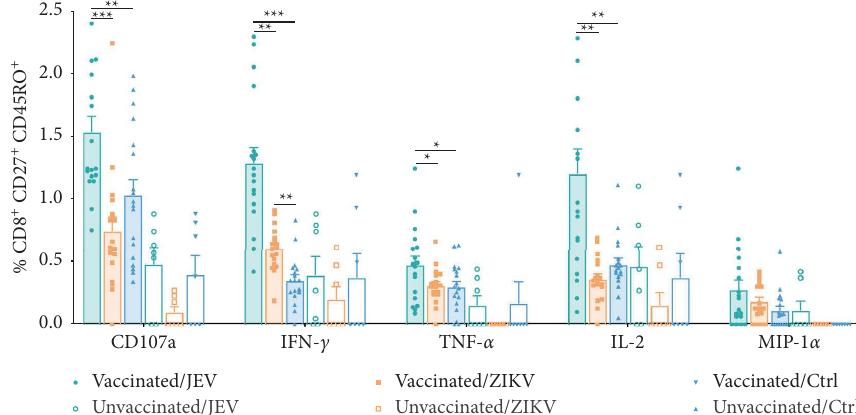
Figure 1: Multifunctional characterization of CD8 + , CD27 + CD45RO + central memory Tcell (T subpopulations were gated on cells expressing at least one of the fve Tcell functions analyzed, and the frequency of cells expressing any of the fve cell functions was assessed. Vaccinated, n � 18; unvaccinated, n � 7. Results are expressed as mean ± SD. Diferences between unmatched groups were compared using an unpaired t -test, the Mann–Whitney U test, or the Kruskal–Wallis rank-sum test with Dunn’s post hoc test for multiple comparisons. ∗ P < 0 . 05, ∗∗ P < 0 . 01, and ∗∗∗ P < 0 .